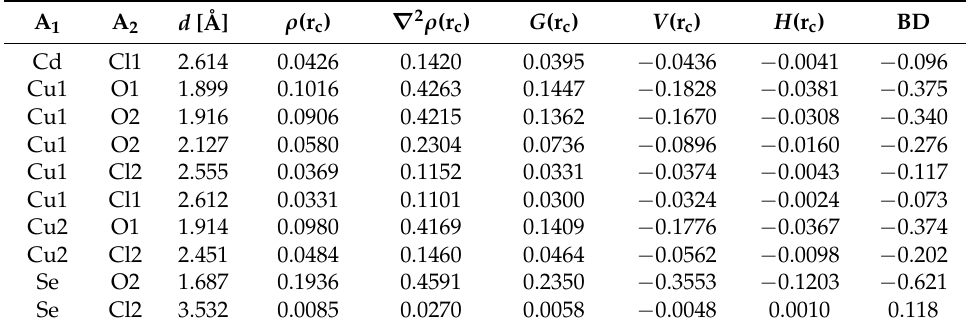
Table 6. Bond critical points in the crystal structure of burnsite, KCdCu 7 O 2 (SeO 3 ) 2 Cl 9 , and their properties.